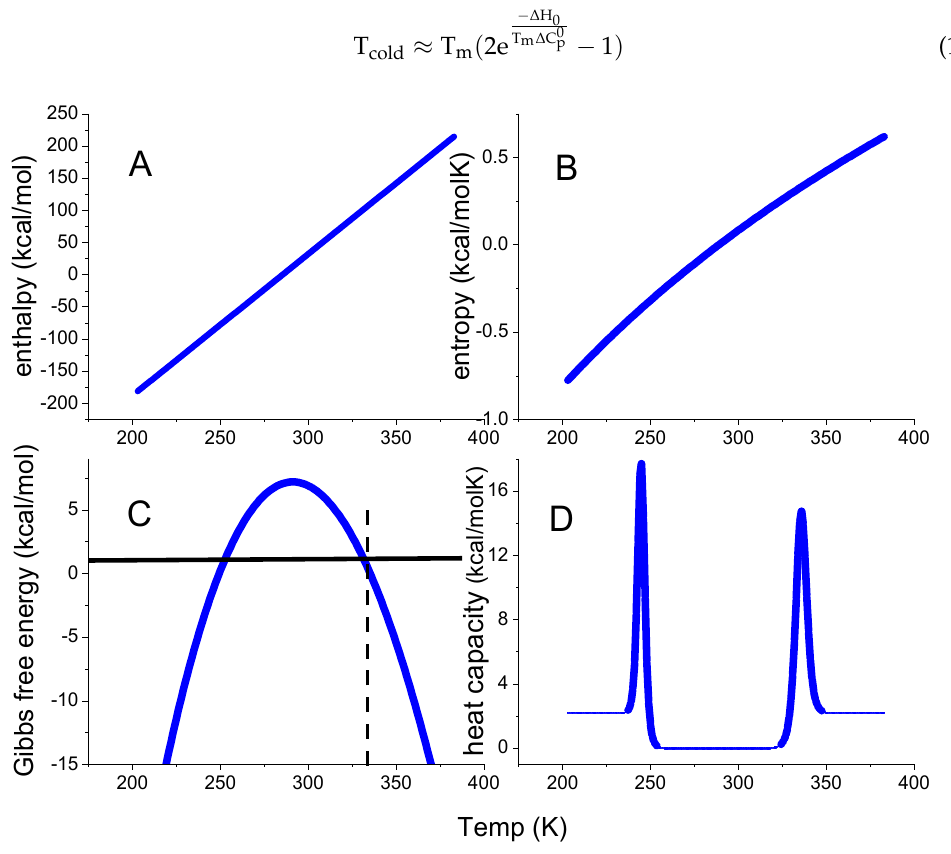
Figure 2. The thermodynamic functions of the standard chemical equilibrium two–state model calculated with the parameters typical for lysozyme, ∆ H 0 = 110 kcal/mol and ∆ C 0 p = 2.2 kcal/molK. Dashed vertical line: midpoint temperature T m = 62 °C. ( A ) Enthalpy Δ H NU (T) (Equation (8)). ( B ) Entropy Δ S NU (T) (Equation (9)). ( C ) Gibbs free energy Δ G NU (T) (Equation (10)). ( D ) Heat capacity C p (T) (Equation (12)).